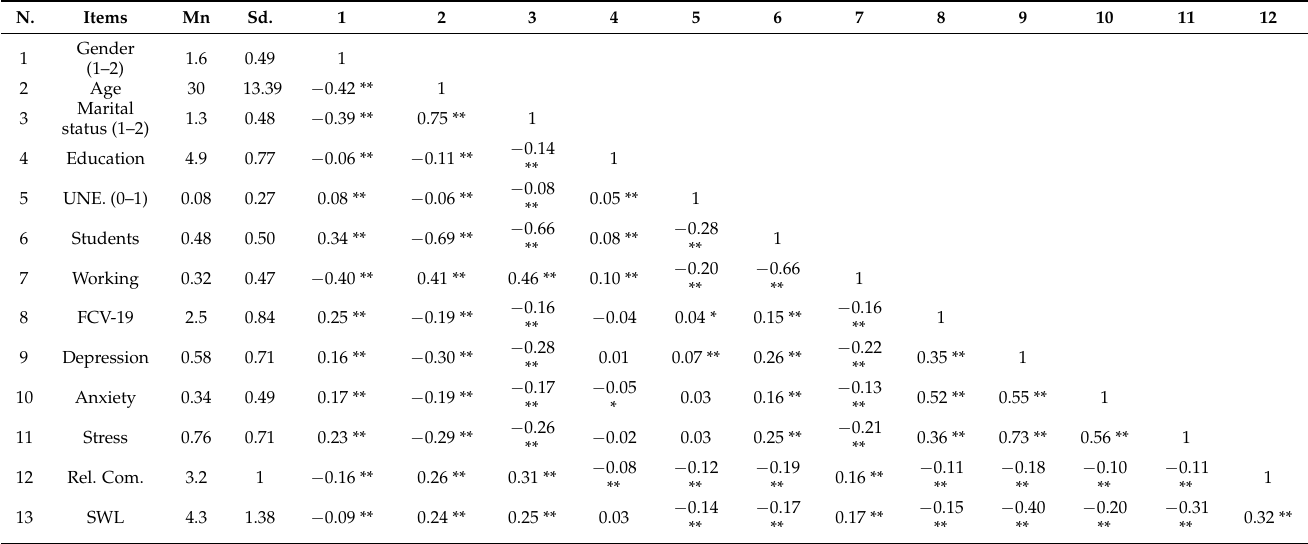
Table 2. Means, standard deviation, and